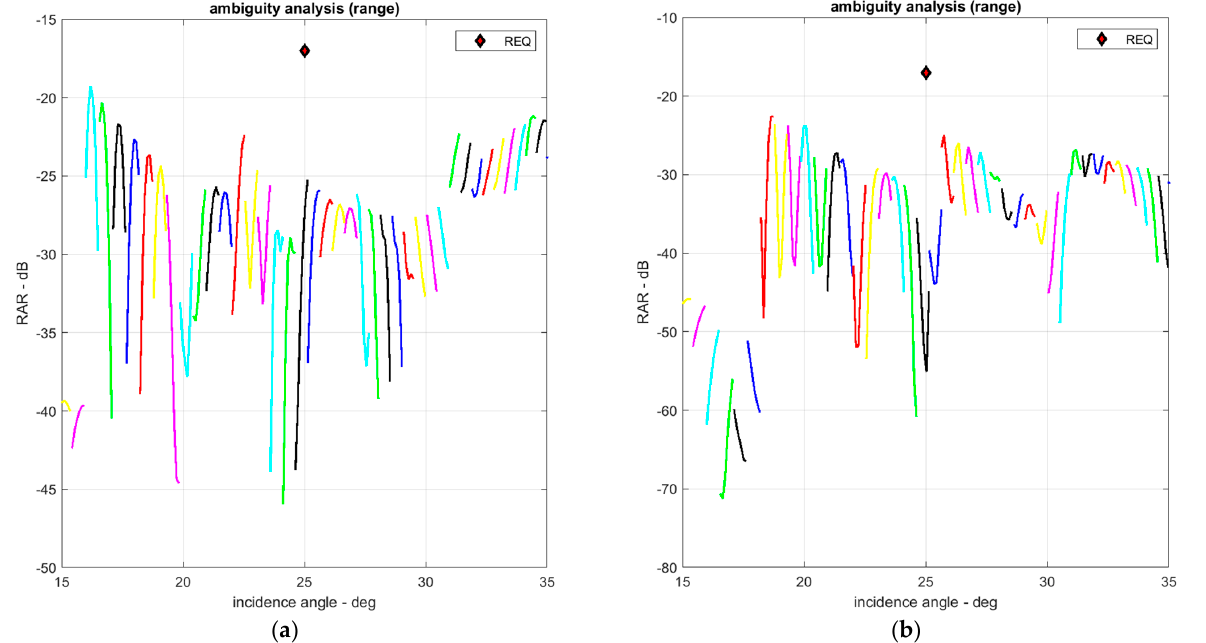
Figure 29. Range ambiguity ratio vs. incidence angle in ( a ) high-resolution and ( b ) wide-swath modes. RAR was lower than the required level of − 17 dB at the incidence angle of 25 ◦ . Each color shows the corresponding